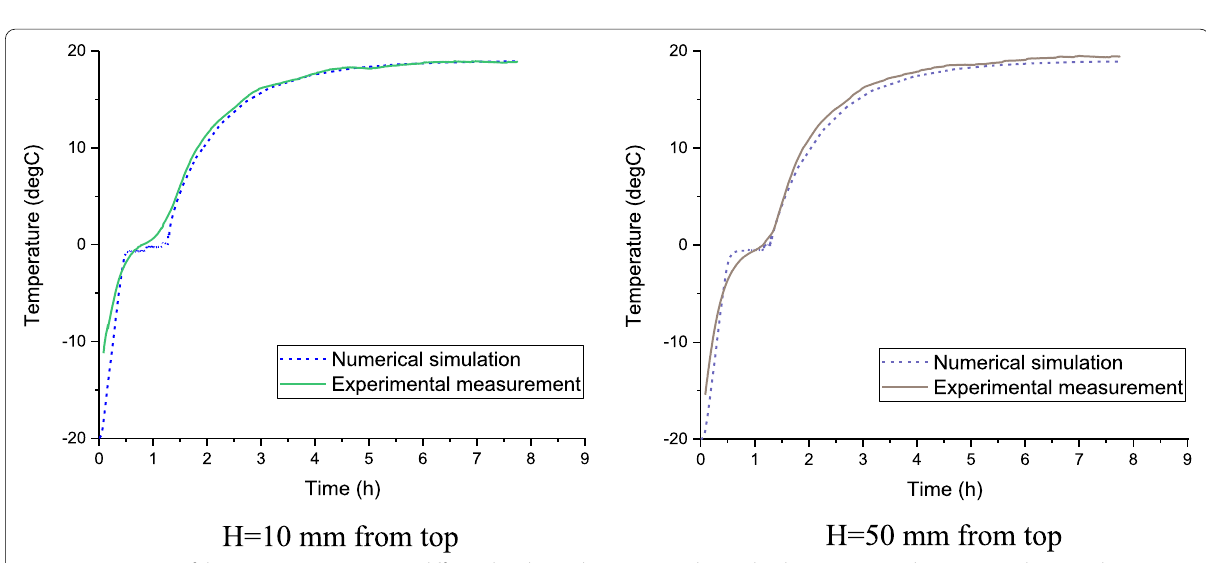
Fig. 5 Comparison of the temperature process at different heights in the specimen during the thawing process by RFEM simulation and experimental